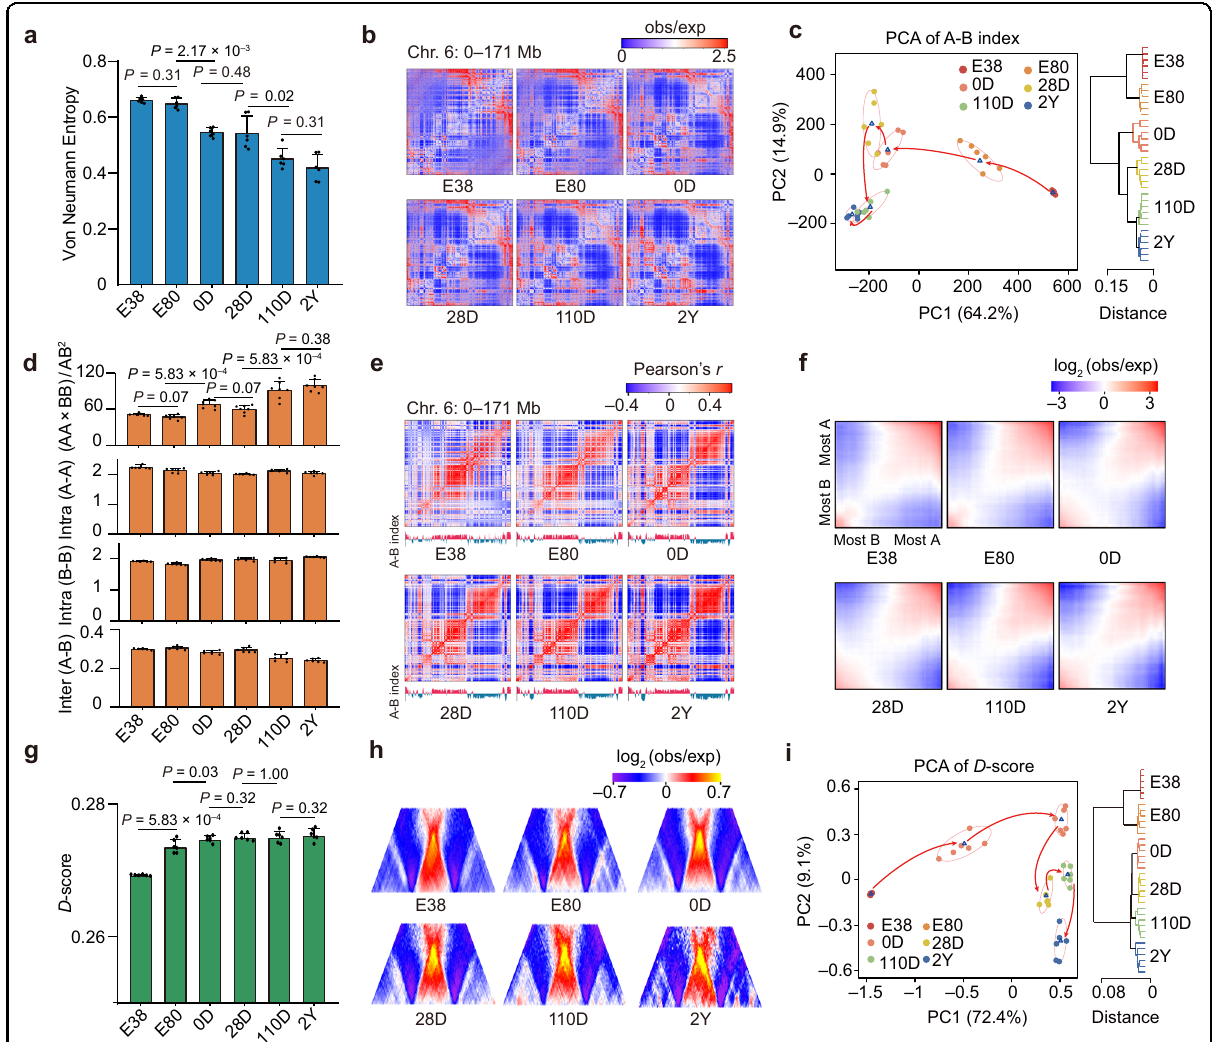
Fig. 2 Global reorganization of hierarchical chromatin structures during liver development. a Quanti fi cation of the disorder in chromatin structure using Von Neumann Entropy (VNE). Higher entropy corresponds to more disordered chromatin structures. Data are shown as means ± SD. The dots on the bars represent the replicates ( n = 6). b Representative observed/expected (O/E) contact maps (100kb resolution) for chromosome 6. c PCA (left) and unsupervised hierarchical clustering (right) of A-B index ( n = 113,298 bins). Blue triangles indicate the centers of minimum volume ellipses. d Changes in compartmentalization strength (calculated as AA × BB/AB 2 ) during development. AA, BB, and AB indicate interaction strength within compartments A, B, and between A and B, respectively. Data are shown as means ± SD. The dots on the bars represent the replicates ( n = 6). e Representative correlation matrices (100 kb resolution) and A-B index for chromosome 6. f Contact enrichment show the extent of compartmentalization in different stages. g D -score of cTADs in each stage. Data are shown as means ± SD. The dots on the bars represent the replicates ( n = 6). h Average TAD representation in each stage. An enrichment in the amount contacts was observed during development. i PCA (left) and unsupervised hierarchical clustering (right) of D -scores for